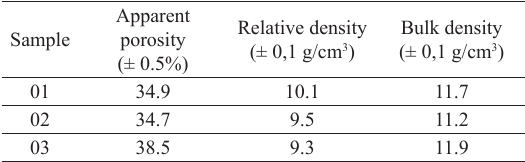
Table 4. Apparent porosity calculated by the Archimedes’ method.